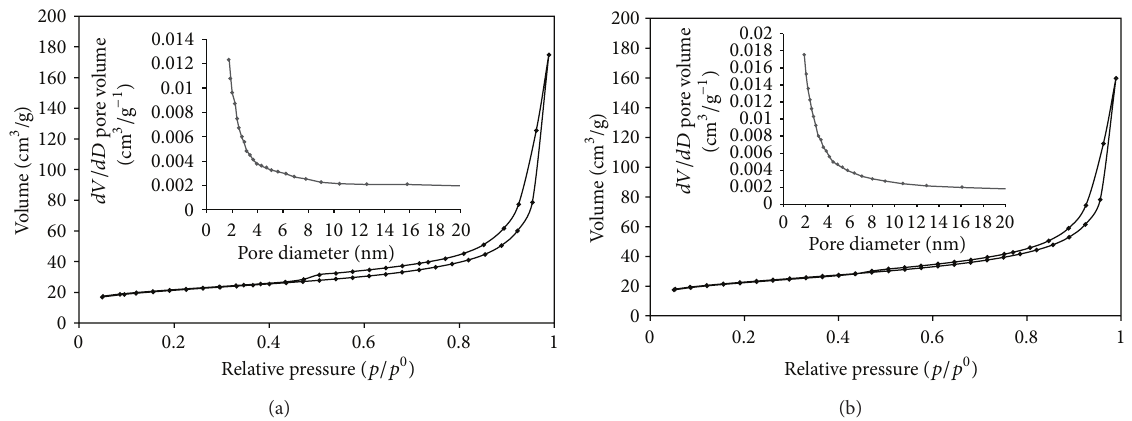
Figure 3: N 2 adsorption-desorption isotherms and pore size distribution curves of (a) SCSH and (b) NSCSH.